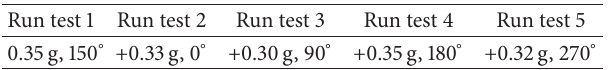
Table 5: Trail weights added on node 5 in each